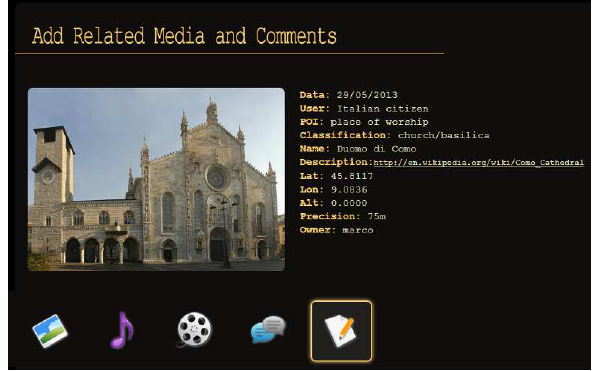
Figure 5. Example of a Web page providing POI